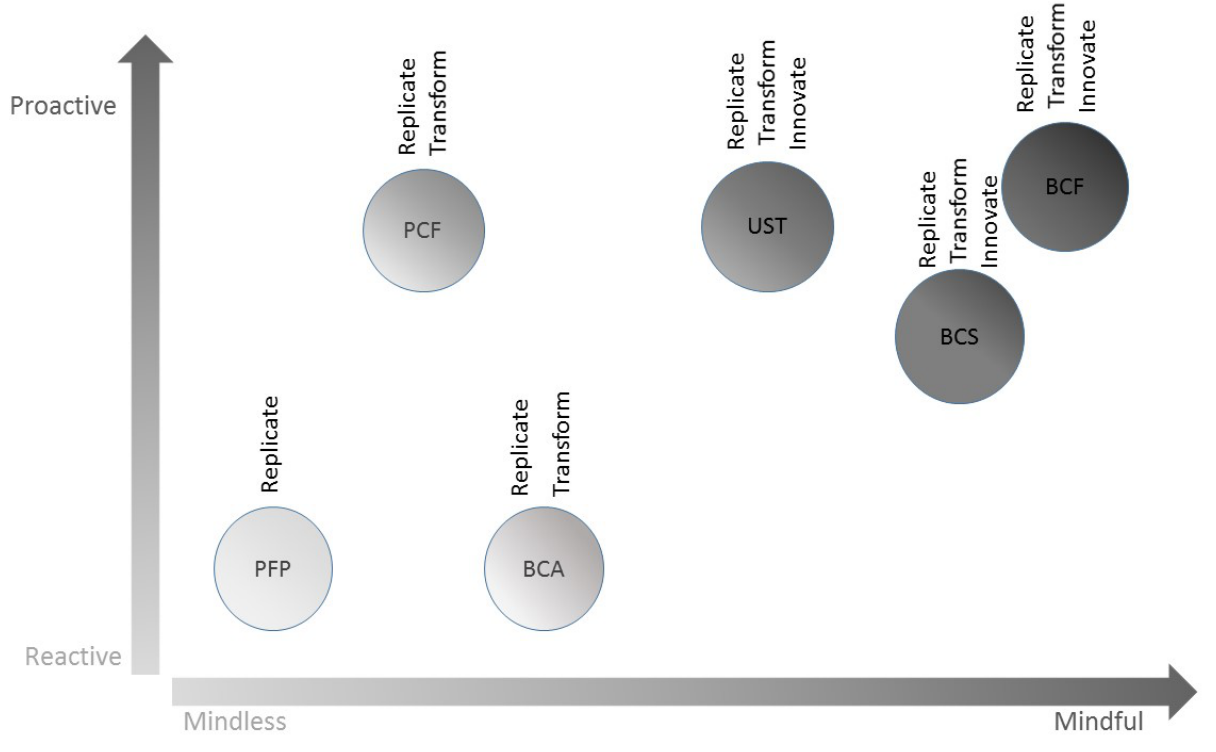
Figure 1. Mindfulness and proactive orientation of the six cases. BCA: Breast Cancer Action; BCF: Breast Cancer Foundation; PCF: Prostate Cancer Foundation; PFP: Pints for Prostate; UsT: Us Too